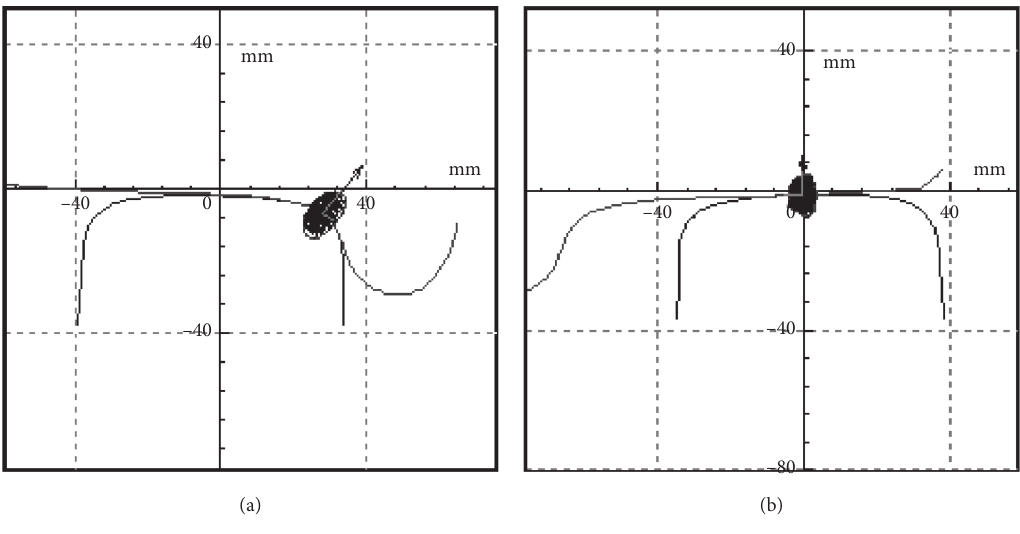
Figure 13: Contact patch diagram. (a) Outside. (b) Inside.